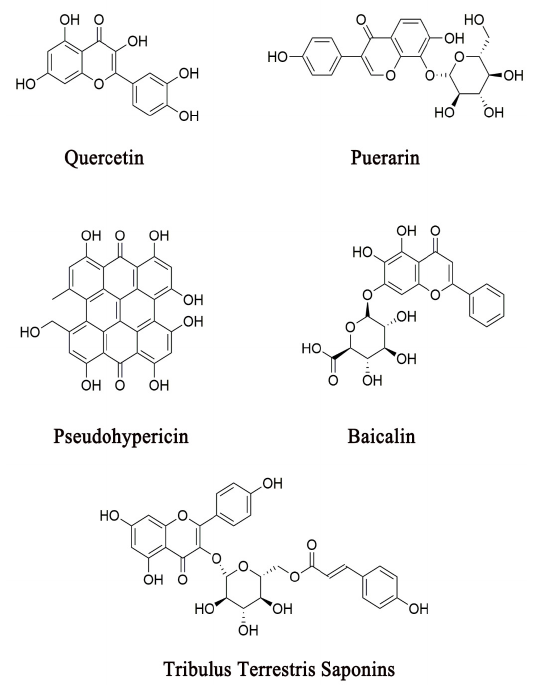
Figure 3. Several representative CHM constituents that have been demonstrated to exhibit antide- pressant-like activities through their action on HPA axis hormone